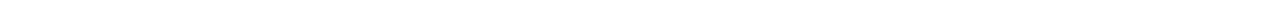
Fig. 5 Astrin-SKAP complex mediates a late step of the end-on conversion process. a Experimental regime: Cells treated with Monastrol and MG132 for 2 h and ZM447439 for 45 min were immunostained using antibodies against Tubulin and SKAP and CREST antisera. DNA was stained using DAPI. b Immuno fl uorescence images of HeLa cells transfected with control, SKAP or Astrin siRNA, as indicated, and treated as in a . Magni fi ed images in the right-most panels correspond to boxed area . Scale bar: 5 μ m. c Single-plane time-lapse images of Z-stacks show the fate of lateral kinetochores ( red ) attached to MTs ( green ) in Control or SKAP siRNA treated HeLa YFP-Tub; CenpB-Red cells in Monastrol. White arrowheads mark the KT tracked. Yellow arrows mark shrinking lateral K- fi bre and white arrows highlight synchronous movement of the KT and MT-end. Scale bar: 2 μ m. d Graph shows percentage of lateral kinetochores that remained lateral (L) or transitioned into other attachment states (D – detached; E – end-on) in time-lapse movies as in c . Error bars represent SEM from four experiments. e Graph of time spent by lateral kinetochores on MT-walls, before changing into another attachment state, in control or SKAP siRNA treated cells. Red and black bars mark mean-time and SD values, respectively, across kinetochores from four independent experiments. # indicates statistically insigni fi cant difference (unpaired Student ’ s t -test). f Immunoblots of lysates of cells treated with control or SKAP siRNA harvested after time-lapse microscopy. Antibodies against SKAP and γ -Tubulin (loading control) were used. g Images of bipolar spindles with congressed chromosomes in control or SKAP siRNA transfected cells treated with MG132 and ZM447439 and immunostained as in a . Scale bar: 5 μ m in uncropped and 2 μ m in cropped images. Boxed areas correspond to cropped images. h Cartoon illustrates SKAP ’ s role in the end-on conversion process: (i) SKAP is selectively recruited to end-on (mature) but not lateral (immature) kinetochores. (ii) SKAP is crucial for the lateral to end-on conversion event but not required for tethering kinetochores onto microtubule walls. Finally, reducing Aurora-B allows end-on attachments in a SKAP dependent